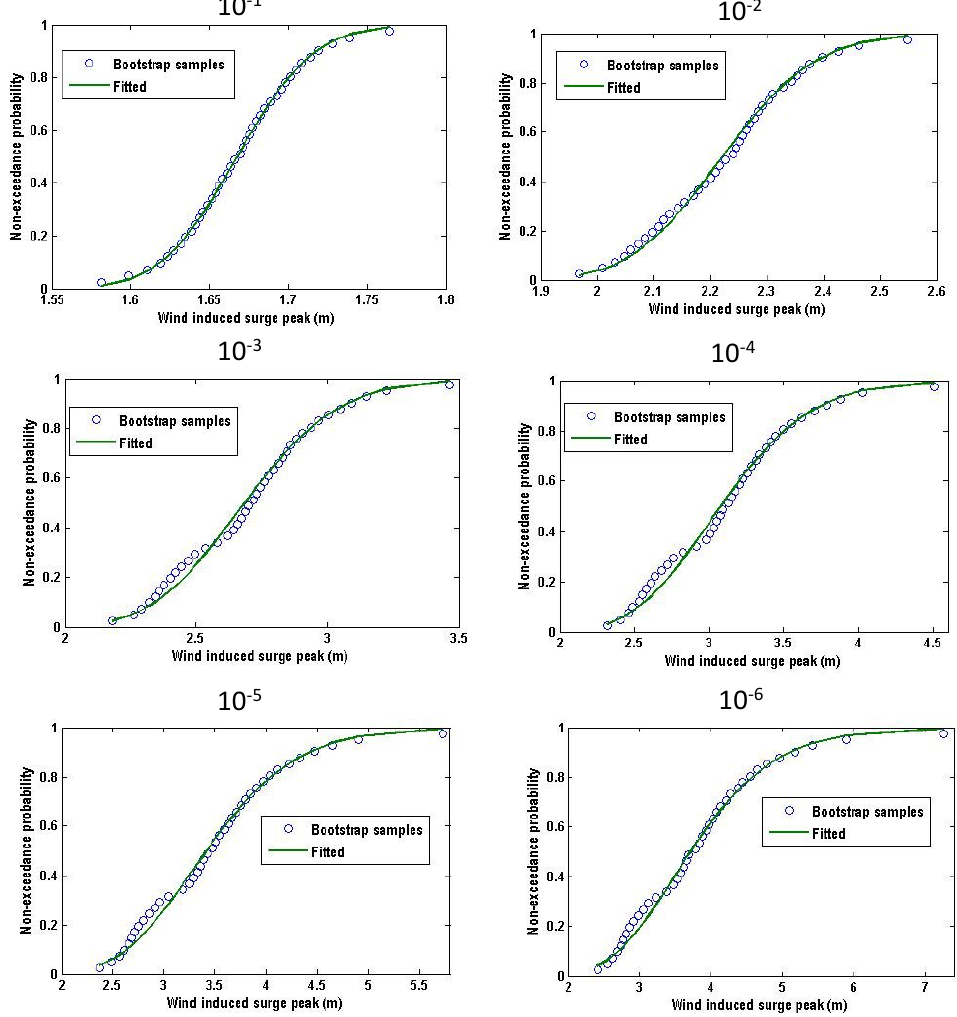
Figure 6. The fitted Log-normal distributions at the exceedance probability of 10 −1 , 10 −2 , 10 −3 , 10 −4 , 10 −5 , 10 −6 of wind induced surge h smax .